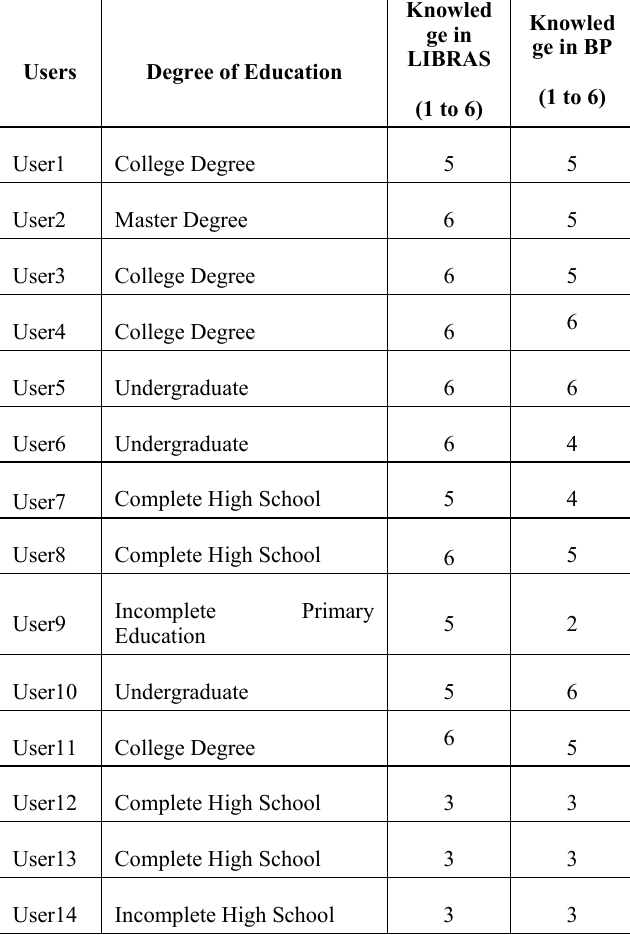
Table 1 - Users’ profile in terms of degree of education